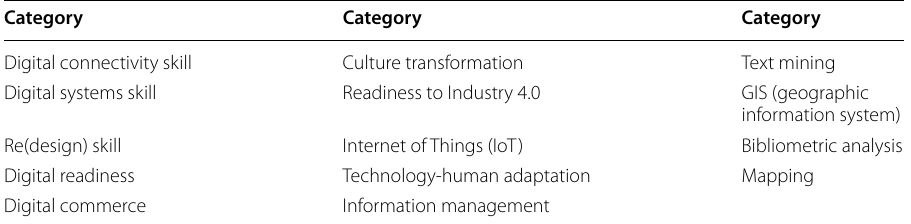
Table 7 Categories (one‑time occurrence) under ’skills’ major